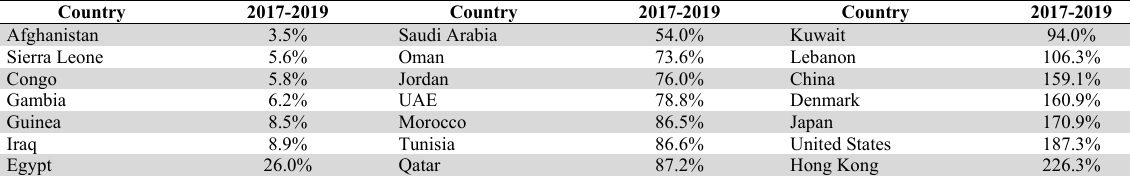
Bank Credit to the Private Sector to GDP Ratio (Top & Bottom 5 Economies & Arab Economies) Country